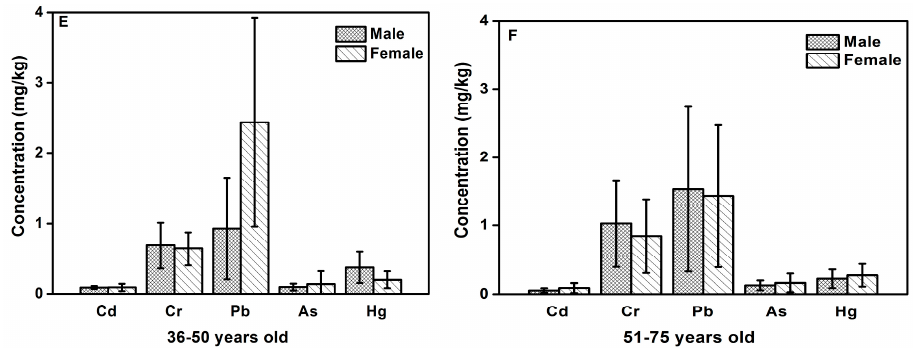
Figure 1. Comparison of hair metal concentrations between genders of different age groups.